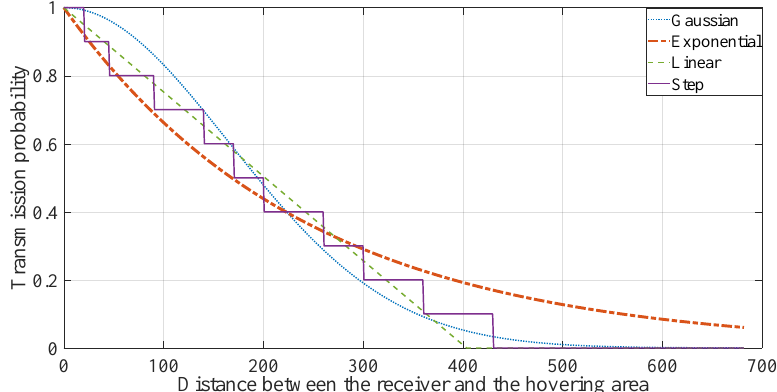
Figure 2. Candidate non-increasing rebroadcast probability functions; the Gaussian, Exponential, Linear, and Step